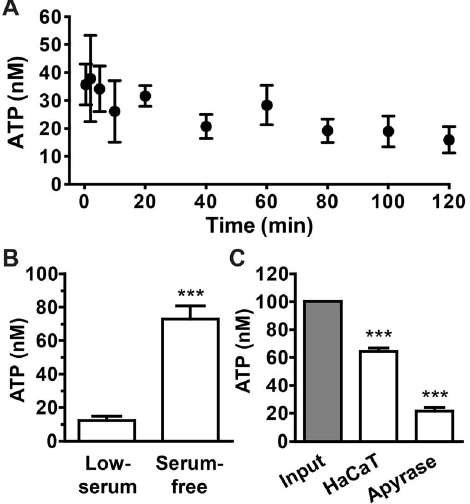
Figure 1. HaCaT cells release ATP and hydrolyze extracellular ATP. (A) Time course of basal ATP levels in the extracellular buffer after a media change. Data represent values from one representative experiment performed in triplicate (mean 6 SD). (B) ATP release from HaCaT cells into the extracellular space with (serum-free) and without (low-serum) the washing step to remove residual fetal calf serum